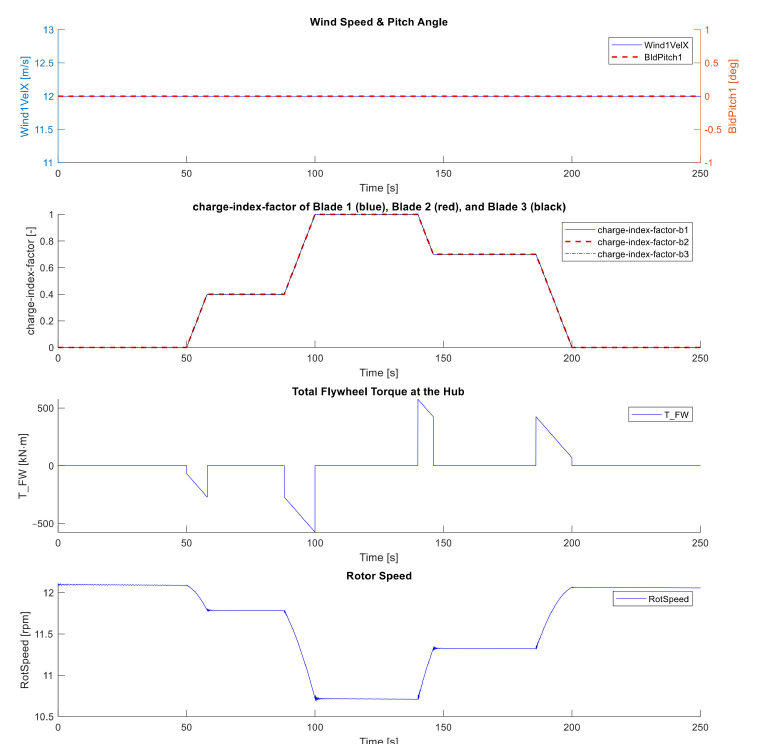
Figure 7. The effect of the FW torque on the rotor speed due to the change in blade elements’